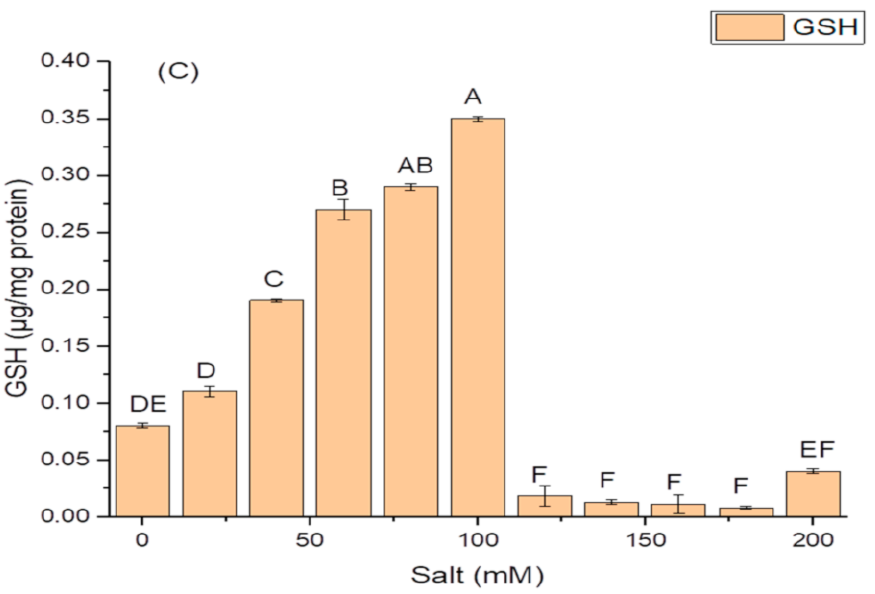
Figure 4. Effect of salt (NaCl) concentrations on ( A ) catalase (CAT) activity; ( B ) superoxide dismutase (SOD) activity; and ( C ) glutathione reductase (GSH) activity of K. variicola SURYA6. Values are the average of five replicates and were analyzed by one-way ANOVA followed by Turkey’s test. Different letters on mean value of each parameter indicate significant differences at p < 0.05.